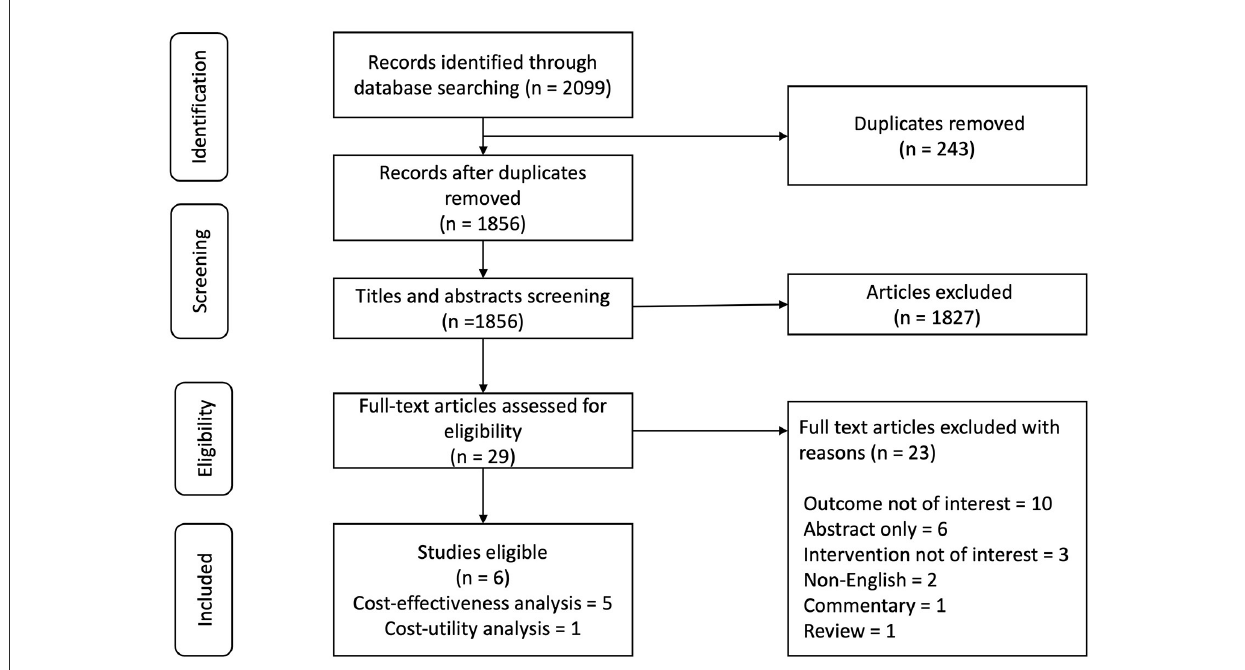
FIGURE1 Flow chart of study retrieval and